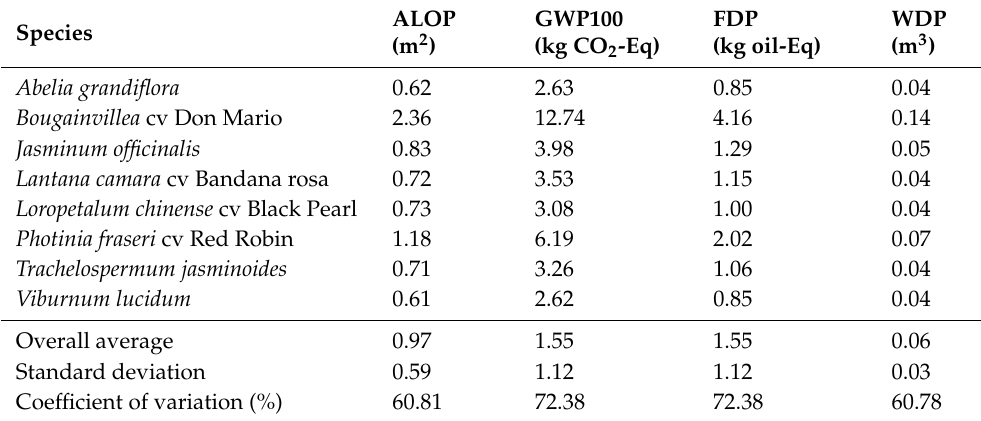
Table 9. Environmental implications variation between two ornamental production models: conven- tional production model (CM) and novel and sustainable production model (NSM), among 8 selected ornamental species of 1000 plants. Values were derived from Tables 7 and 8.